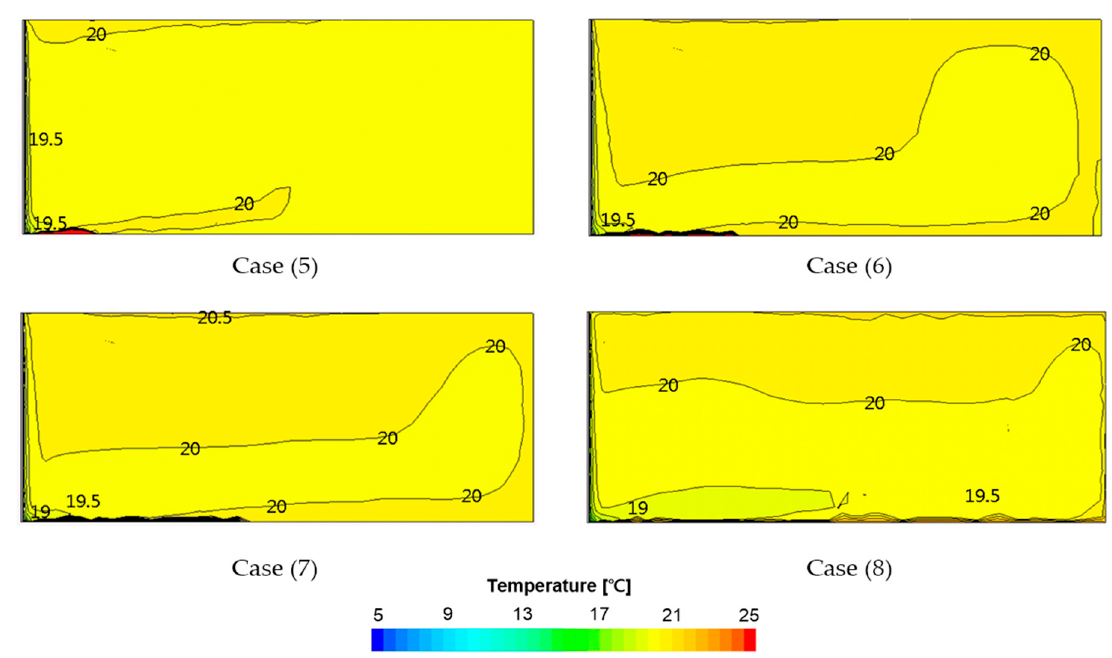
Figure 12. Velocity profiles.